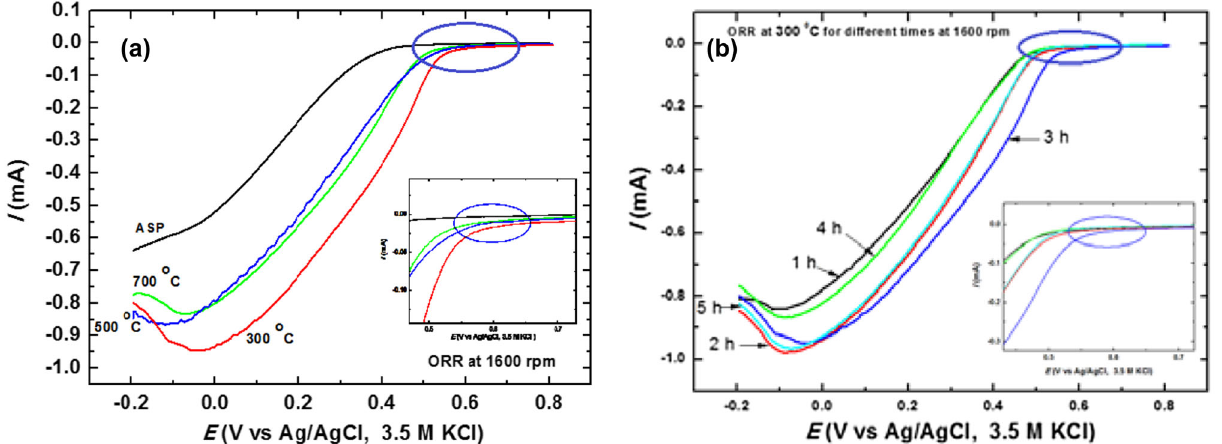
Fig. 4 Single scan voltammograms for PdNi/C catalyst calcined a at different temperatures and b at 300 (cid:3) C for different